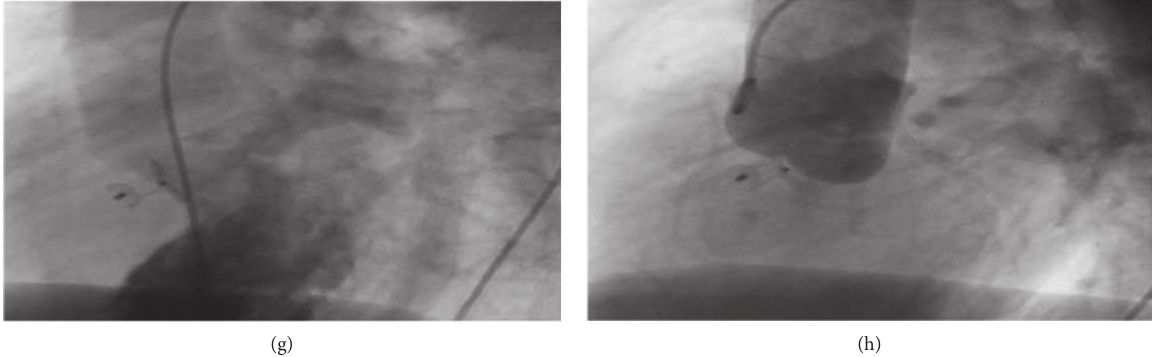
Figure 2: (a) Cross-sectional echocardiogram in the long axis parasternal view for a 21-year-old female patient showing a significant subaortic stenosis with broad-based fibromuscular ridge below a perimembranous subaortic VSD with about 20% aortic override. (b) Color flow imaging from the long axis parasternal view demonstrates the location of the defect with left-to-right shunt and long broad-based subaortic ridge with peak systolic pressure gradient of 36mmHg across the LVOTand mild-to-moderate AR. (c) Parasternal long axis 2D echocardiographic image demonstrates the aortic disc of ADO-I; 10–8mm (red arrow) was pulled towards the subaortic fibromuscular ridge (green arrow) and VSD (yellow arrow). (d) Parasternal long axis 2D echocardiographic image with color flow mapping demonstrates excellent position of the device closing the VSD and compressing the ridge against the interventricular septum (IVS) with mild AR. The peak systolic pressure gradient across the LVOT decreased to 17mmHg. (e) Left ventricular angiogram in the left anterior oblique (70 ° ) and cranial (30 ° ) projection demonstrates a small-sized subaortic perimembranous VSD with a mild aortic override of approximately 20%. The peak systolic pressure gradient across the LVOT was 31mm Hg. (f) Aortogram in the left anterior oblique (60 ° ) projection revealing a prolapse NCC with mild-to-moderate AR (yellow arrow). (g) Left ventricular angiogram in the left anterior oblique (70 ° ) and cranial (30 ° ) projection demonstrating no residual shunt across the VSD and obvious aortic override. (h) Aortogram in lateral (90 ° ) and cranial (20 ° ) projections demonstrating proper device position with trivial AR. The peak systolic pressure gradient across the LVOT declined to